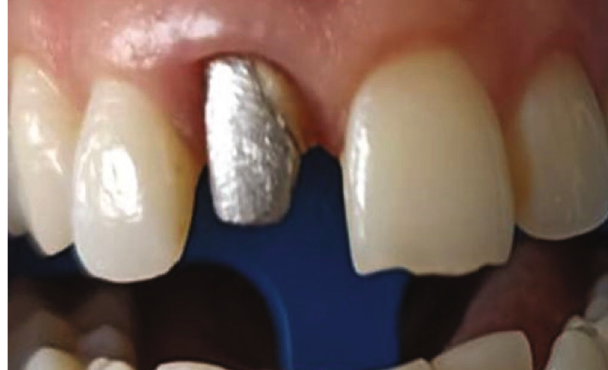
Figure 4: After the cementation of the metallic post and core.